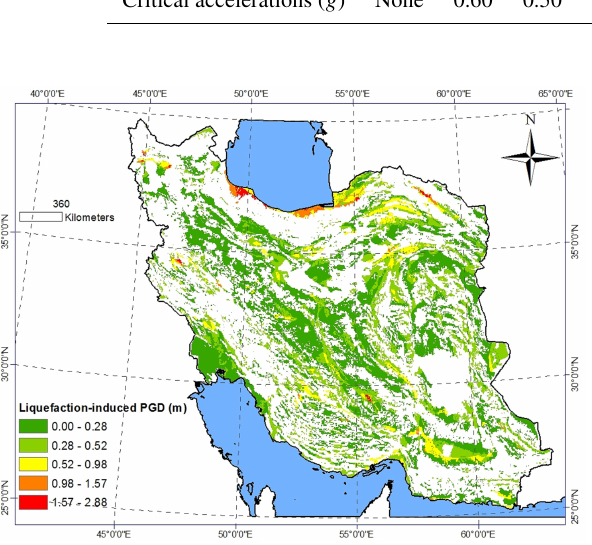
Figure 13. Critical acceleration map of Iran.